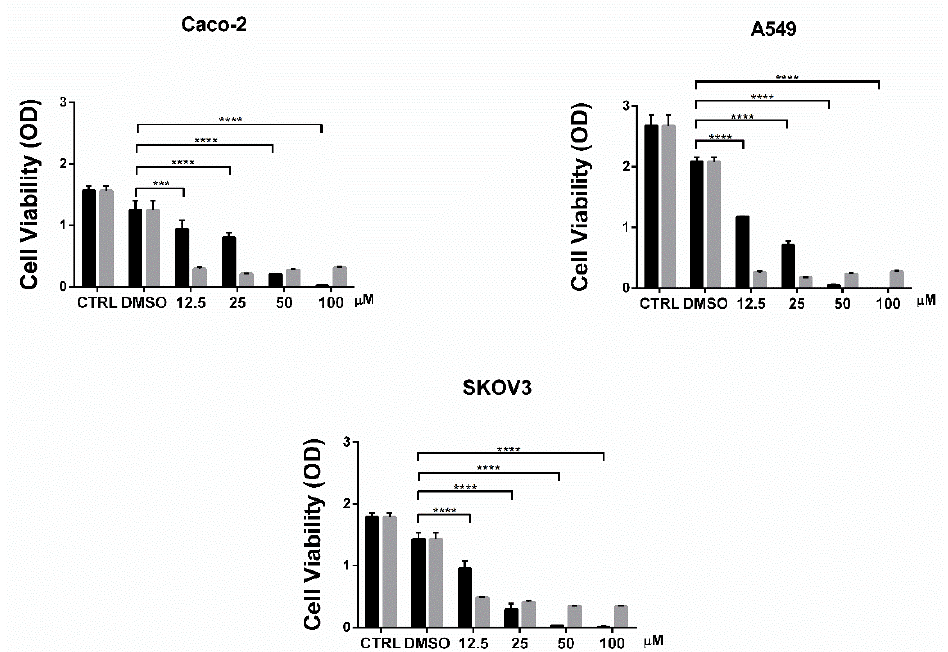
Figure 4. Cell viability assay in the presence of MMV024937 and TPT. Cytotoxicity of MMV024937 (black) and TPT (gray) were tested on three different cancer cell lines; Caco-2 (top left panel), A-549 (top right panel), and SKOV-3 (bottom panel). The figure reports cumulative data analyzed by a two-way ANOVA test, with mean ± SD values. **** p < 0.0001 and *** p < 0.001.